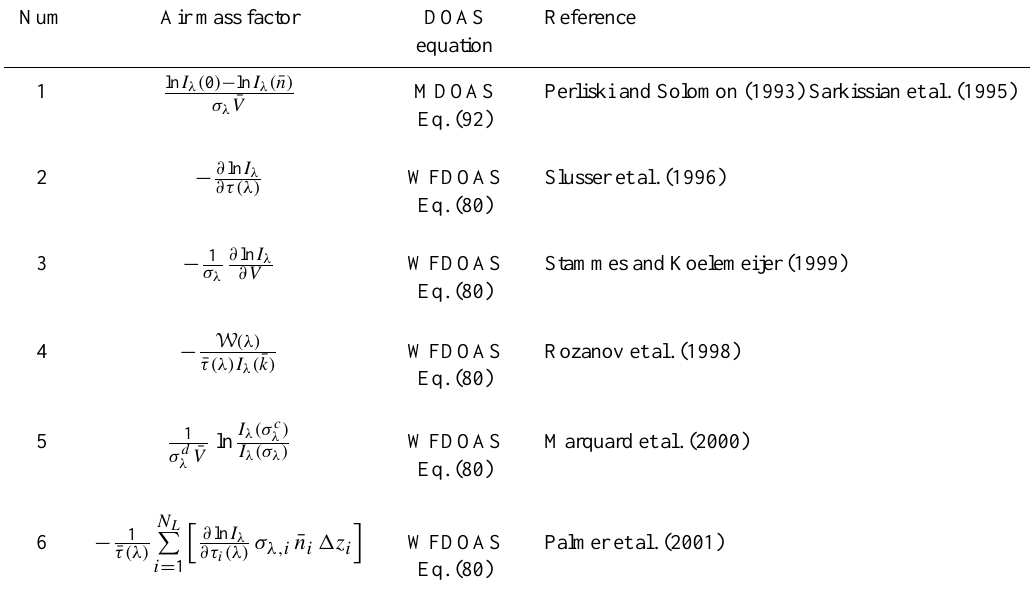
Table 5. Alternative expressions for the air mass factor proposed in previous publications and appropriate DOAS equations. Num Air mass factor DOAS Reference equation Perliski and Solomon (1993) Sarkissian et al.